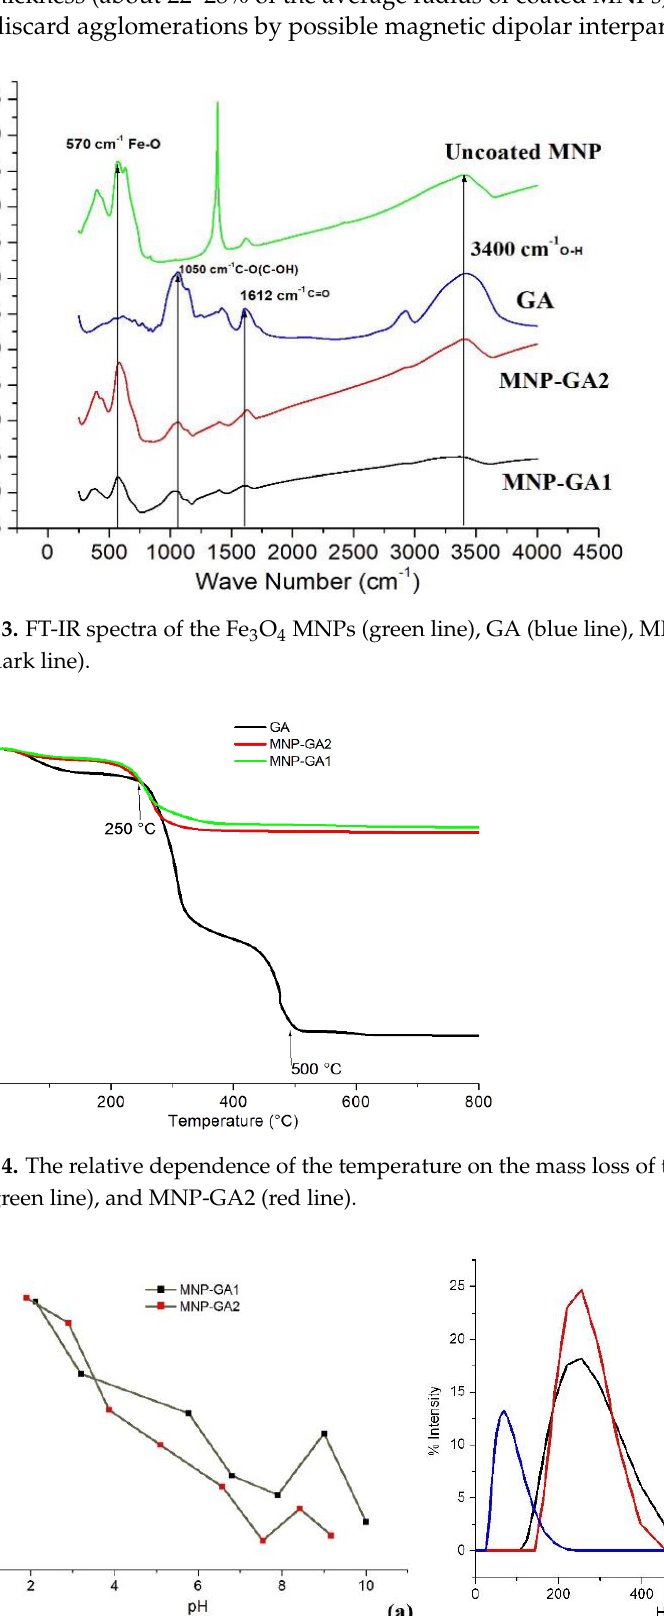
Figure 5. ( a ) pH-dependence of the zeta potential of MNP-GA1 and MNP-GA2 and ( b ) the corre- sponding hydrodynamic diameters of MNP-GA1 (at pH = 7.7) and MNP-GA2 (at pH = 7.5).